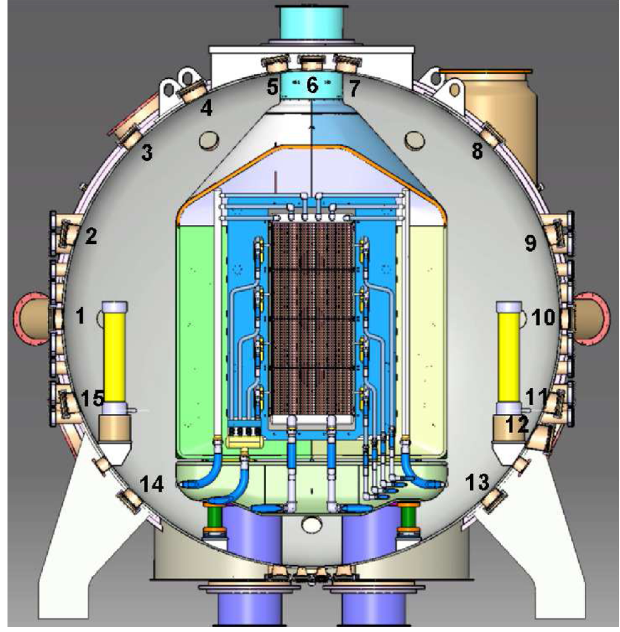
FIG. 1. SPIDER vacuum vessel cross section. The 15 ports used for the tomography diagnostic are numbered clockwise starting from the left equatorial